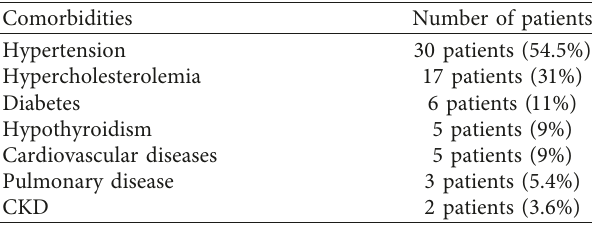
Table 2: Patients’ comorbidities.